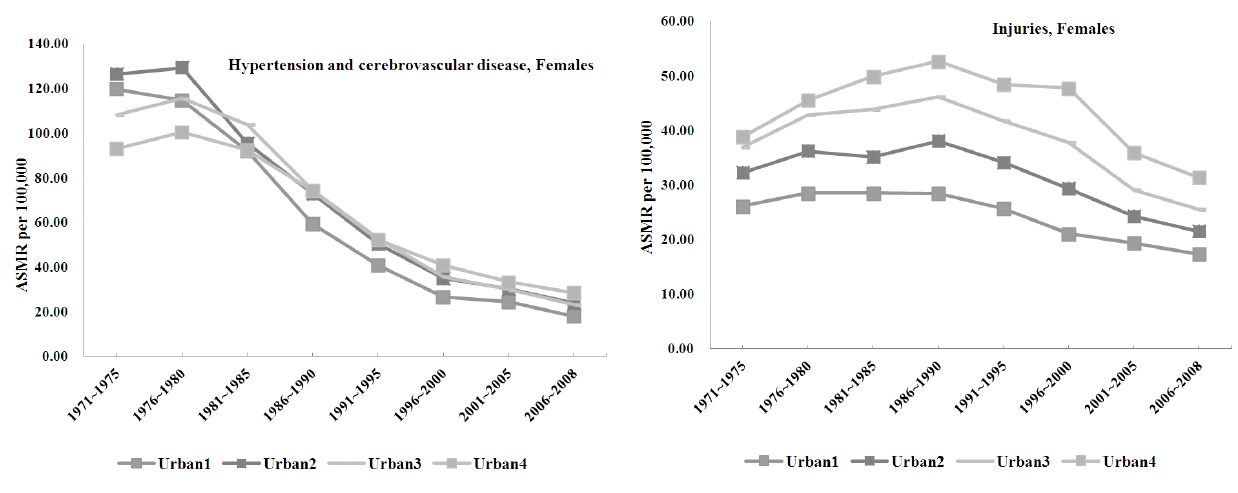
Figure 3. Avoidable Mortality by Urbanization Rates: Injuries, Hypertension, IHD, Lung Cancer (a: females, b: males). (a) ASMR for